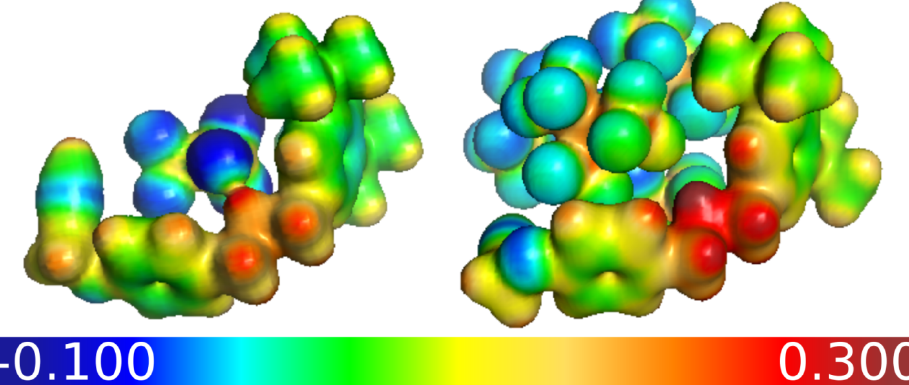
Figure 4. Electrostatic potential maps of A1 -OTf ( left ) and A1 -pf ( right ) in atomic units, with the isosurface value set to 0.02 a − 3 , obtained at the SMD/M06-2X/def2-TZVP level of theory. A color bar 0 is added to indicate the potential at the